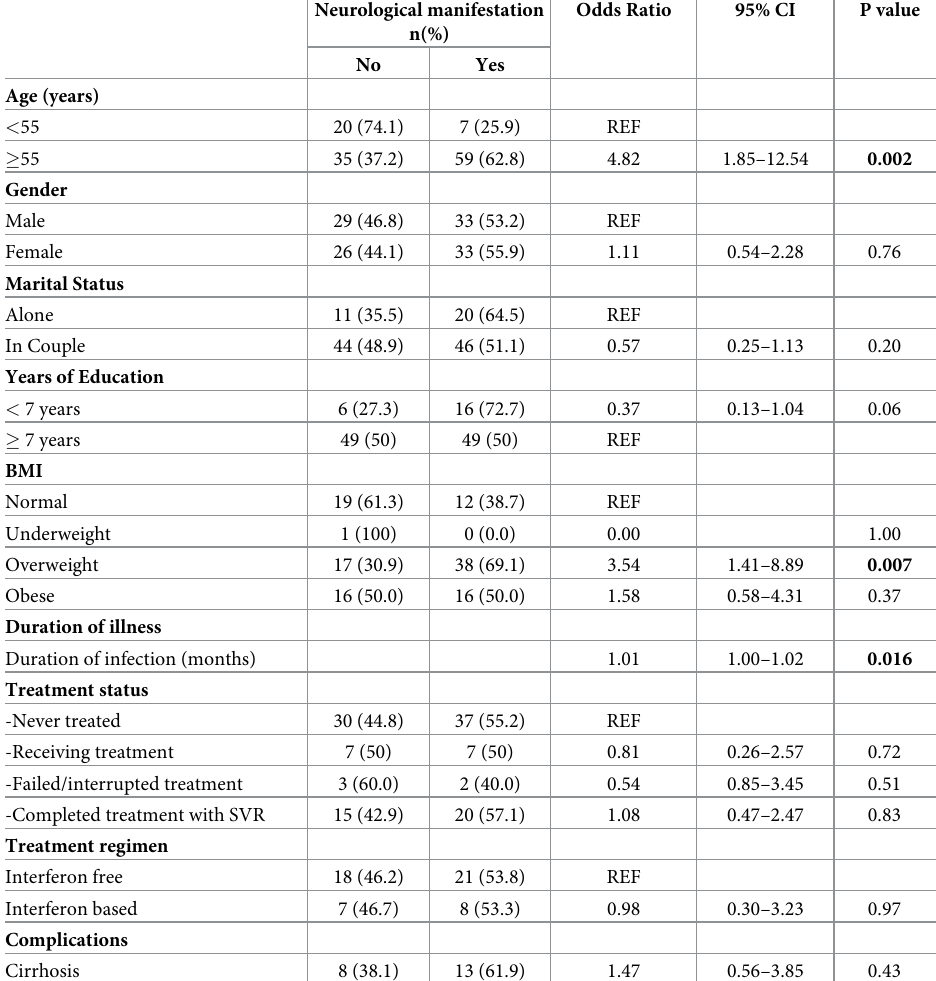
Table 7. Clinical factors associated with neurological manifestations in hepatitis C infected